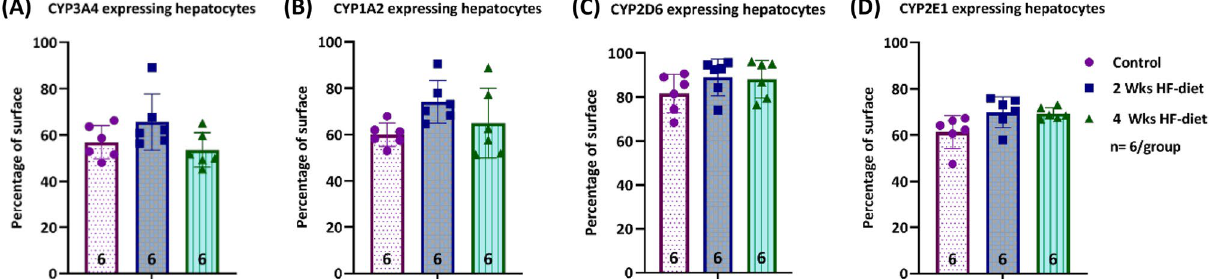
Figure 3. Quantification of CYP-expression using the pattern recognition algorithm. ( A – D ) No significant difference in CYP3A4, CYP1A2, CYP2D6, and CYP2E1 expression pattern in terms of relative surface covered by positively stained hepatocytes, sample size of each group displayed in the bottom of the bar.